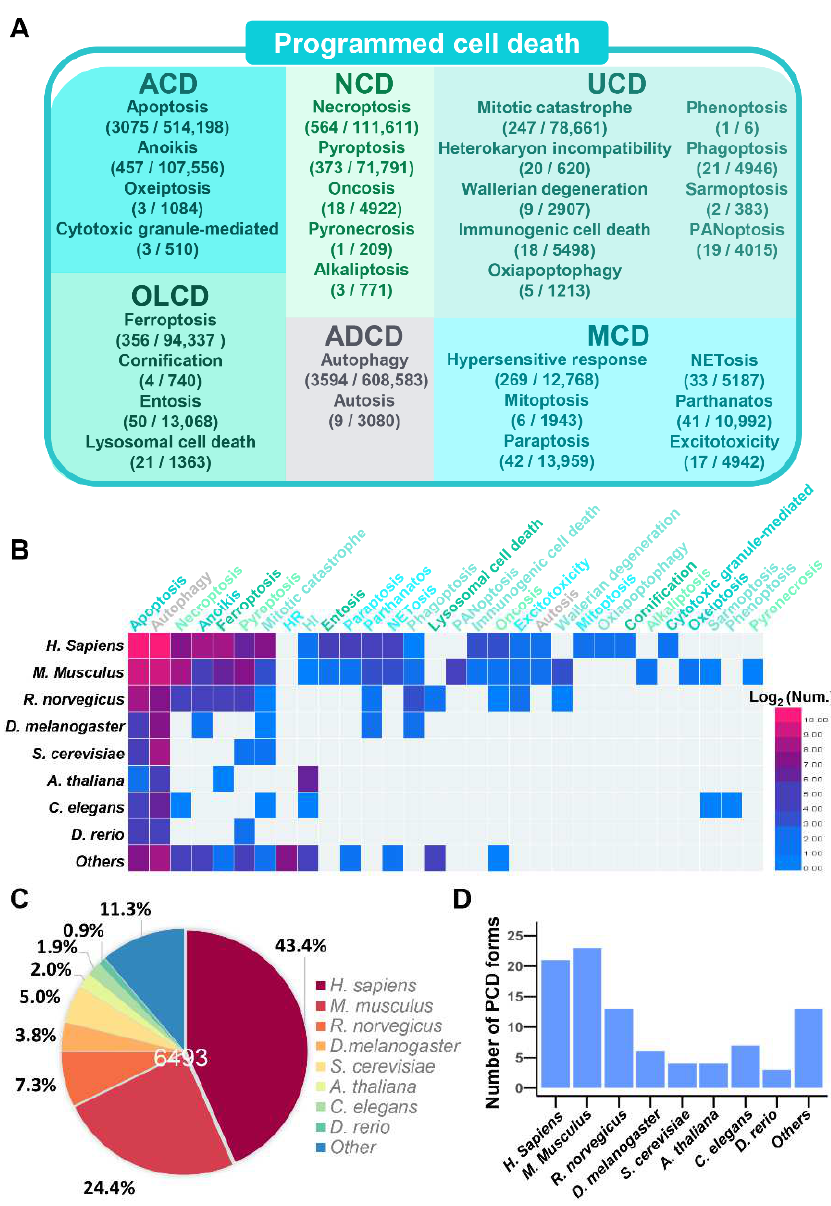
Figure 2. The data statistics of PCD regulators in the iPCD. ( A ) The numbers of PCD regulations and computationally identified PCD regulators are shown according to classification. ( B ) The distribution of experimentally identified PCD regulators in 8 model organisms. ( C ) The percentage distribution of experimentally identified PCD regulators in 8 model organisms. ( D ) The numbers of PCD forms in 8 model organisms.